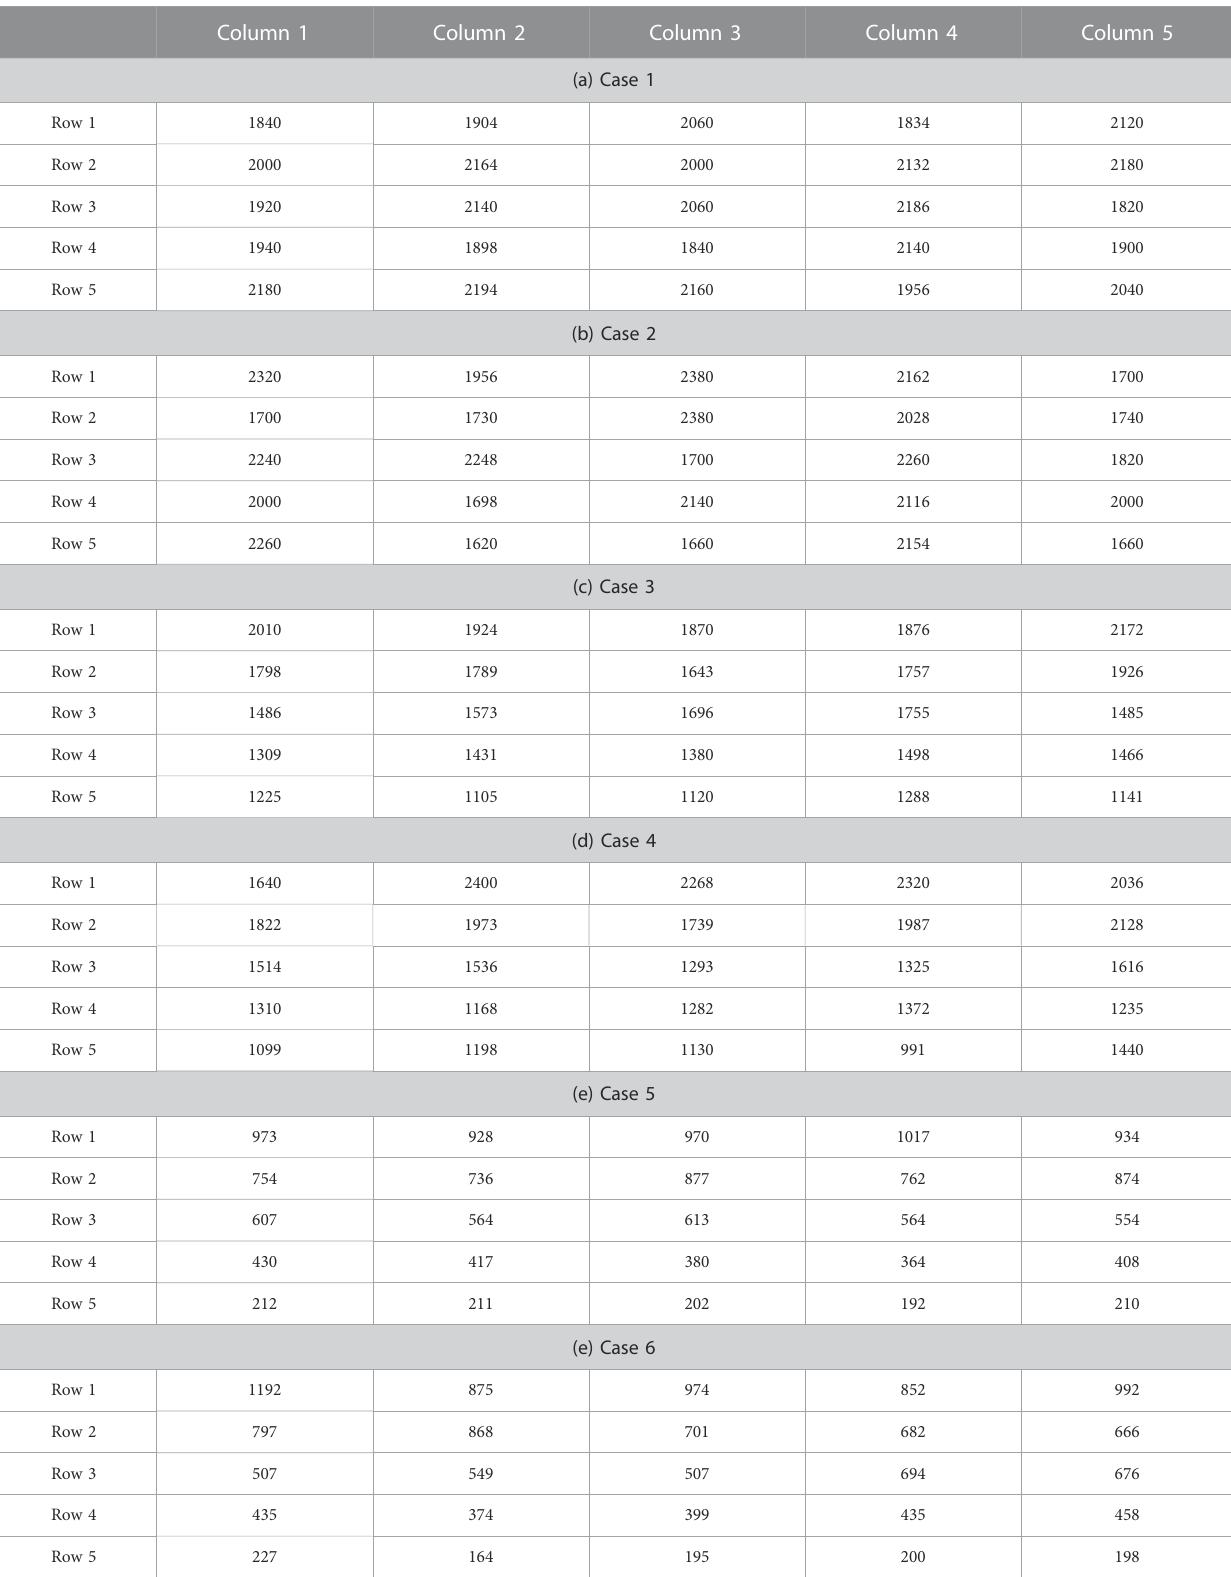
TABLE 2 Six irradiative conditions (units: W/m 2 ). Column